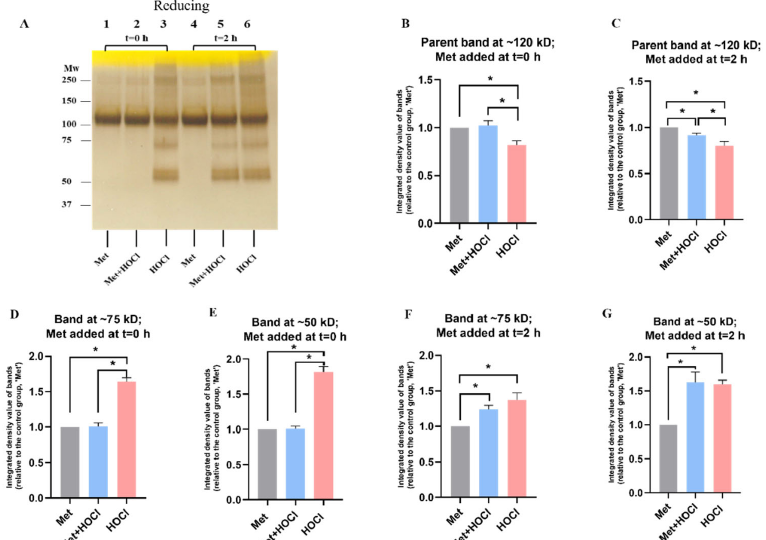
Figure 4. Effects of methionine on HOCl ‐ mediated oxidation on rhAggrecan as detected by SDS ‐ PAGE with subsequent silver staining. ( A ) rhAggrecan (643 nM) was exposed to 78 ‐ fold molar excesses of HOCl (i.e., 50 μ M) for 24 h at 37 °C in buffer A, in either the absence (PBS added) or presence of Met (1 mM, 20 ‐ fold molar excess over HOCl). The Met was added either before the HOCl (t